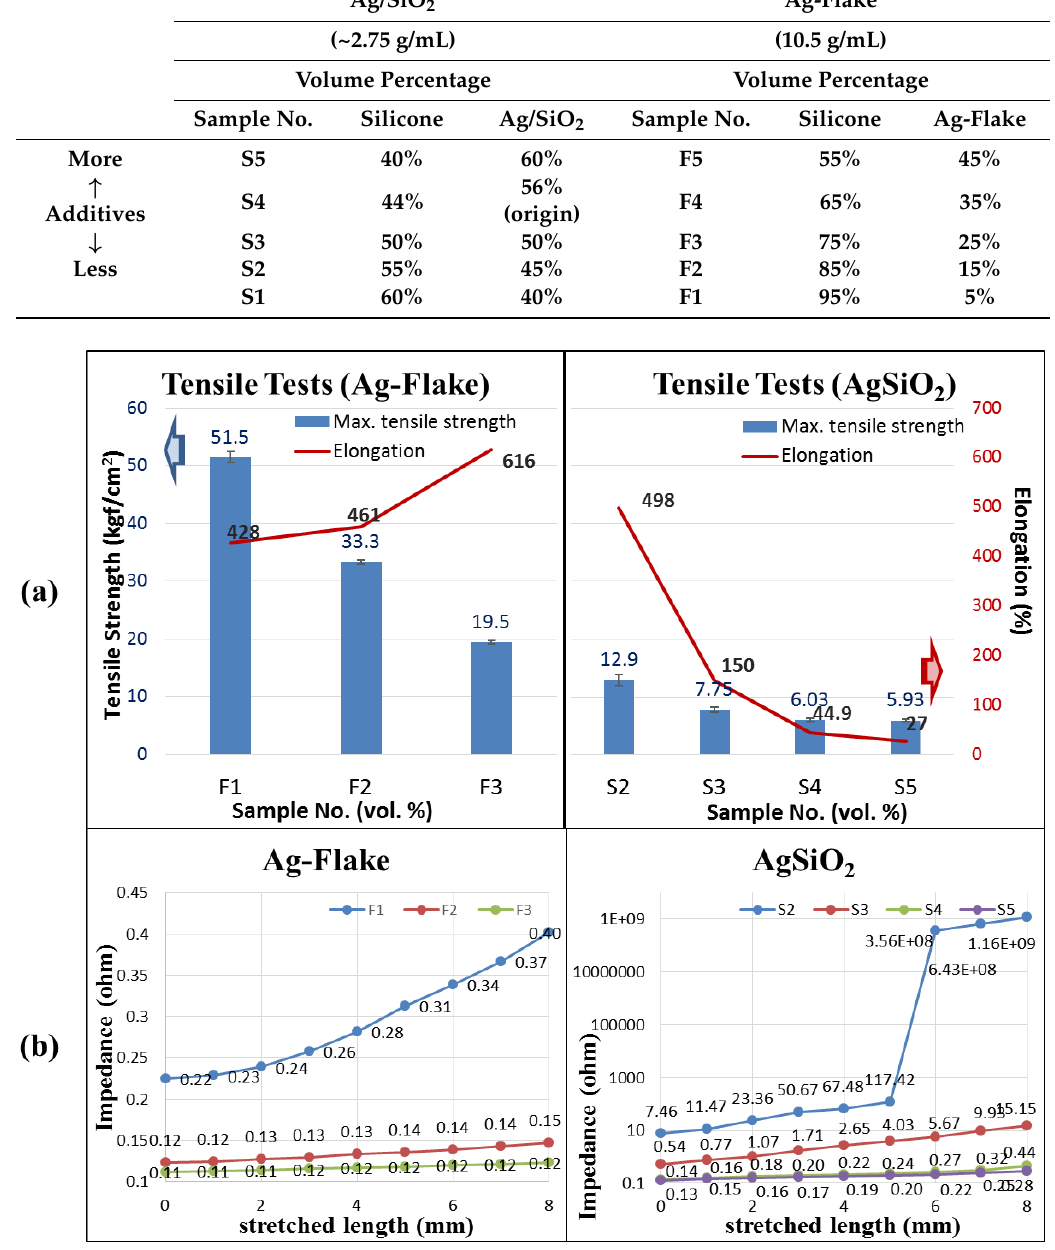
Table 1. The list of several samples of different proportions of additives (Ag/SiO 2 and Ag-flake).